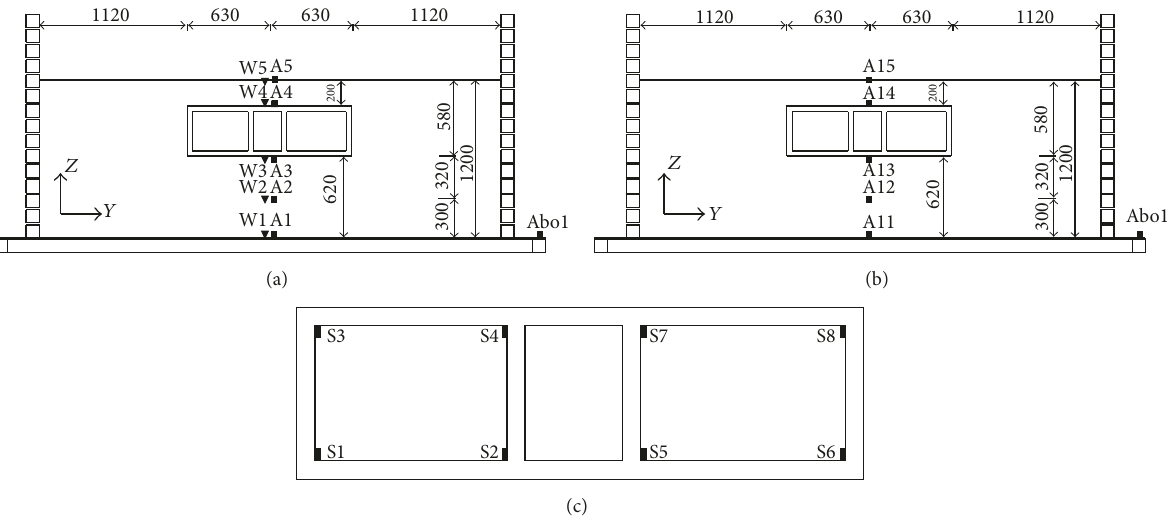
Figure 6: Plane view of instrumentation used during the tests: (a) accelerometers and pore pressure transducers on observation surface I, (b) accelerometers and pore pressure transducers on observation surface II, and (c) strain gauges installed in element 2 (unit: